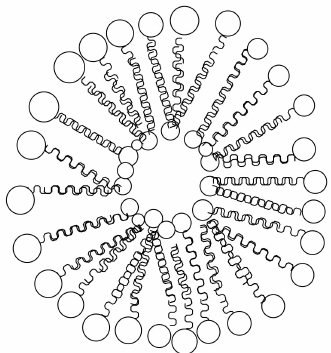
Figure 5. Schematic diagram of